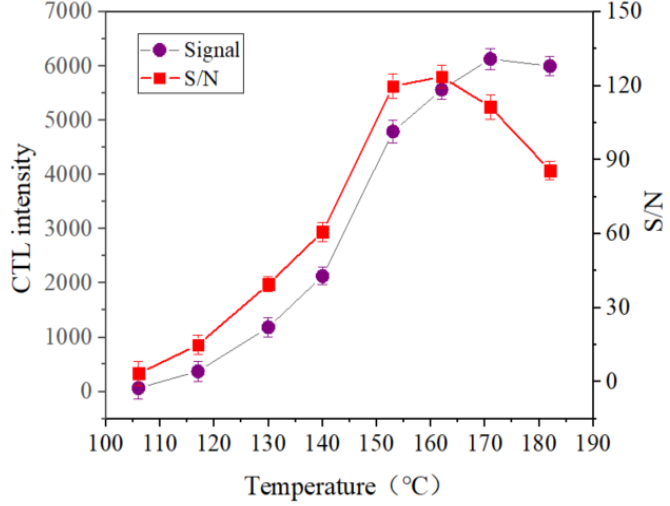
Figure 7. Effect of working temperature on CTL intensity and S/N (concentration: 33.75 ppm; flow rate: 280 mL/min).